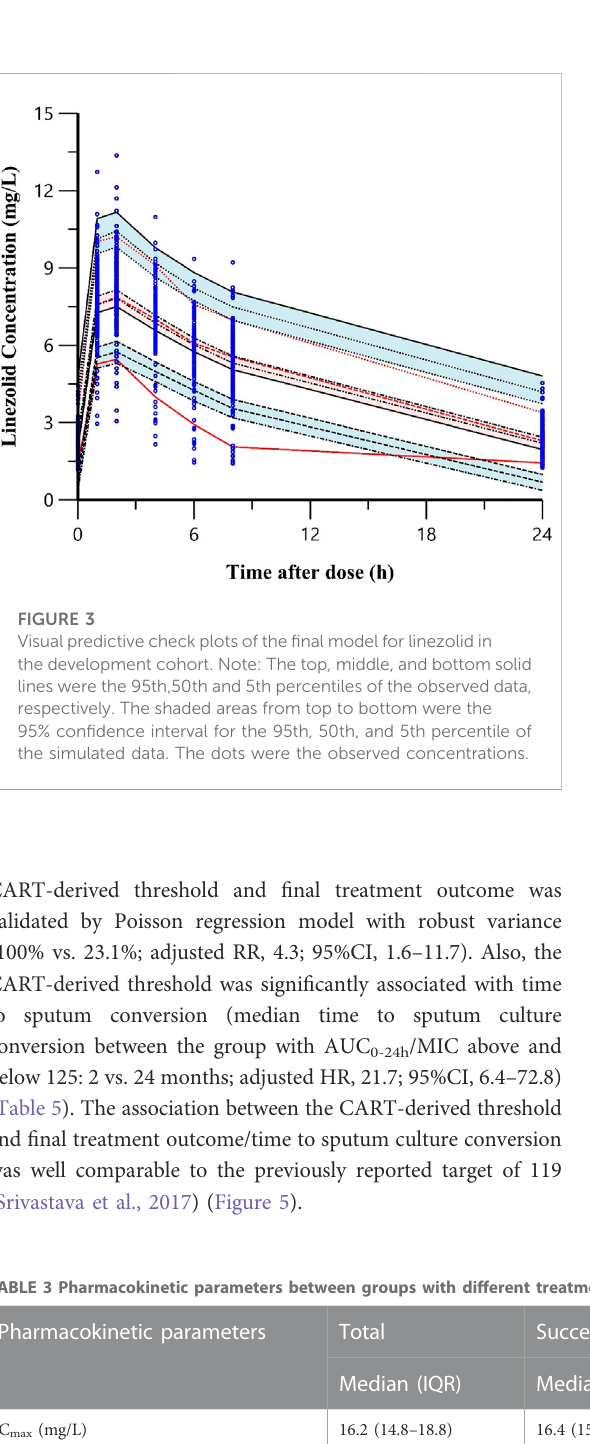
TABLE 3 Pharmacokinetic parameters between groups with different treatment outcomes in validation cohort. Pharmacokinetic parameters Total Successful treatment Unsuccessful